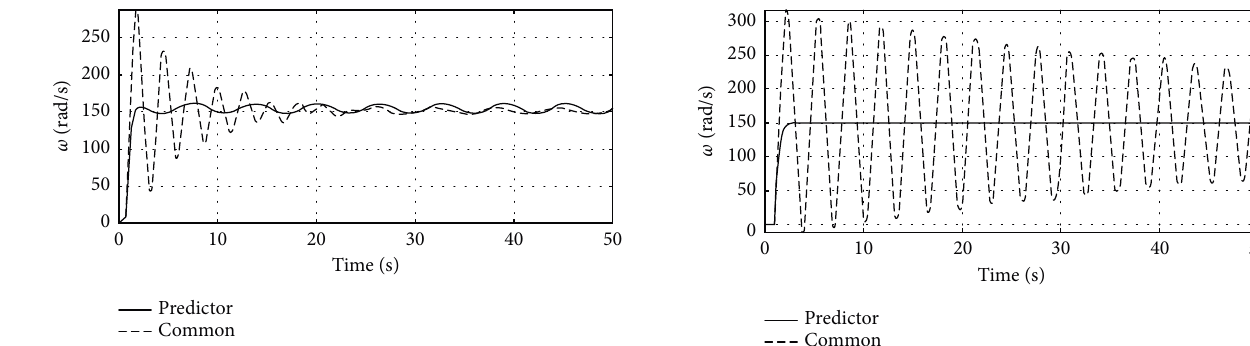
Figure 16: Comparing a predictive-based H controller for τ � 1s. common H ∞